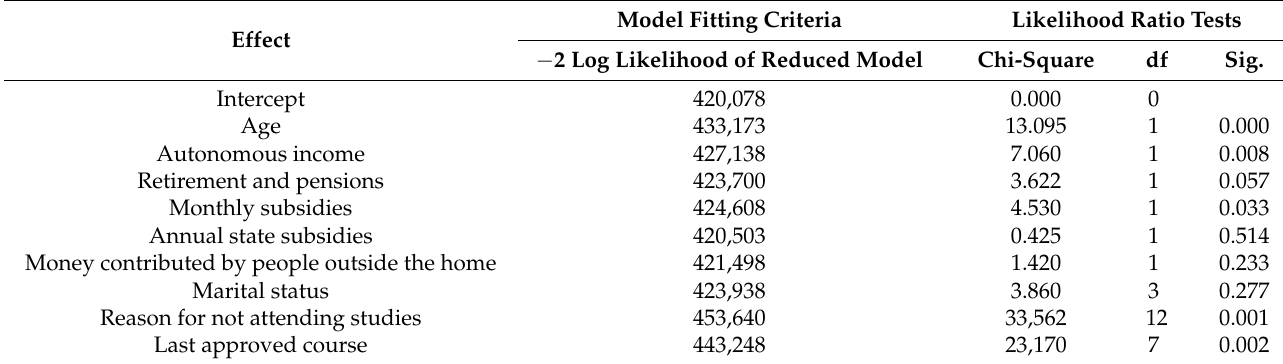
Table 4. Multinomial logistic regression of job opportunities for people with disabilities in